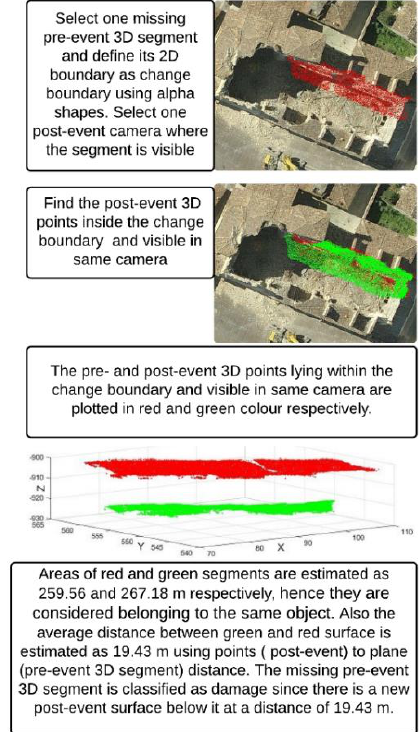
Figure 5. Example for missing 3D segment classified as damaged and the surface below it is visible in